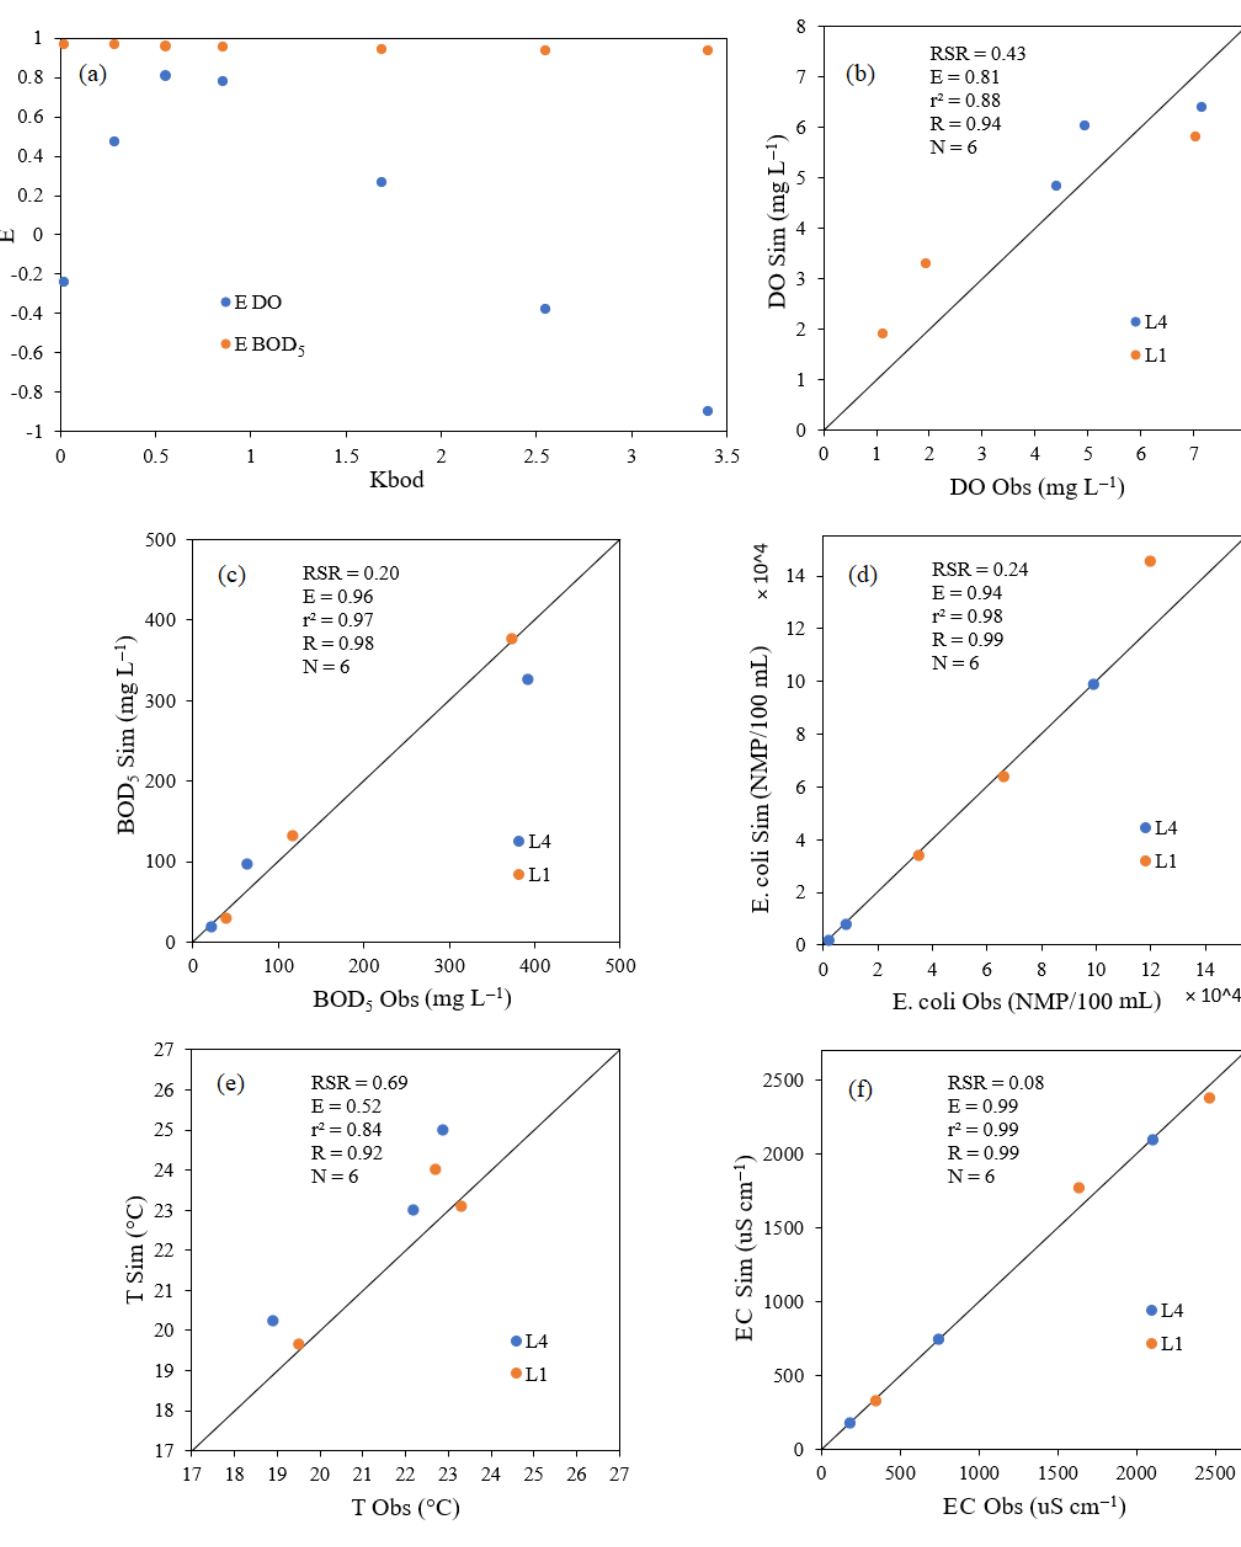
in March, May, 𝐾𝐾 𝑑𝑑𝑑𝑑𝑑𝑑